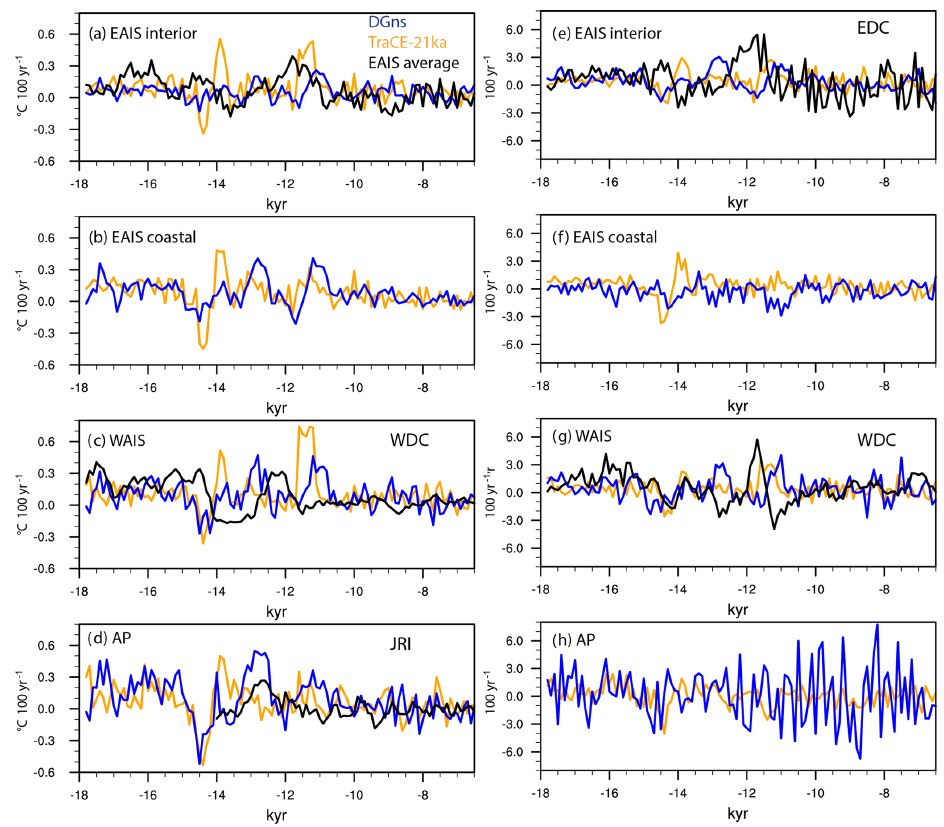
Figure 4. Centennial-scale rates of (a–d) surface temperature change ( ◦ C) and (e–h) relative accumulation change (%; DG ns in blue, TraCE- 21ka in orange, ice cores in